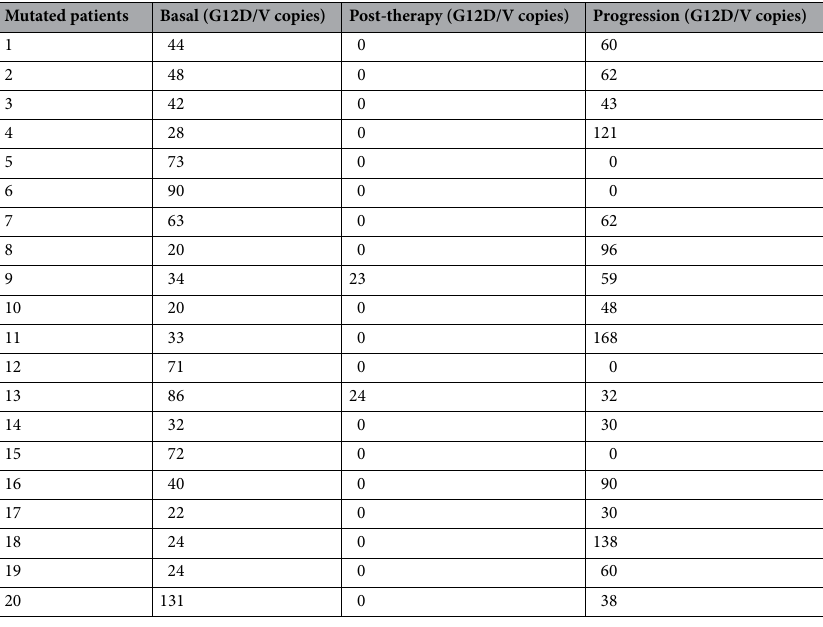
Table 4. 90% of mutated mCRC patients became wild type after the first line chemotherapy but this status reverted in mutated one at progression in 85% of cases.